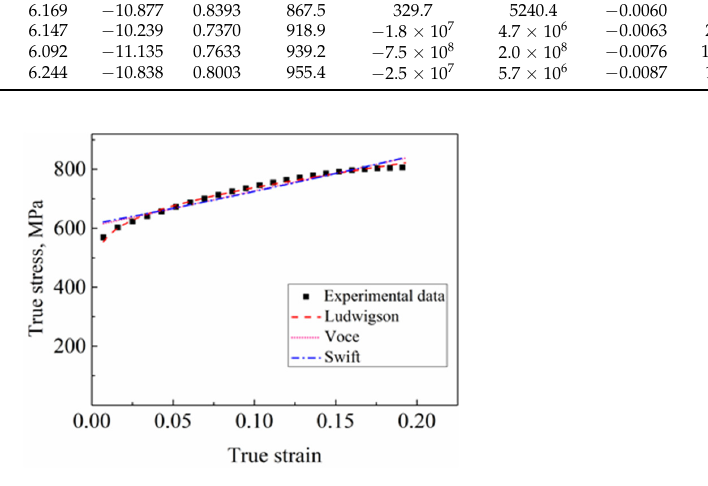
Figure 8. Three model-fitting curves of true-stress–true-strain curve with 0% deformation.